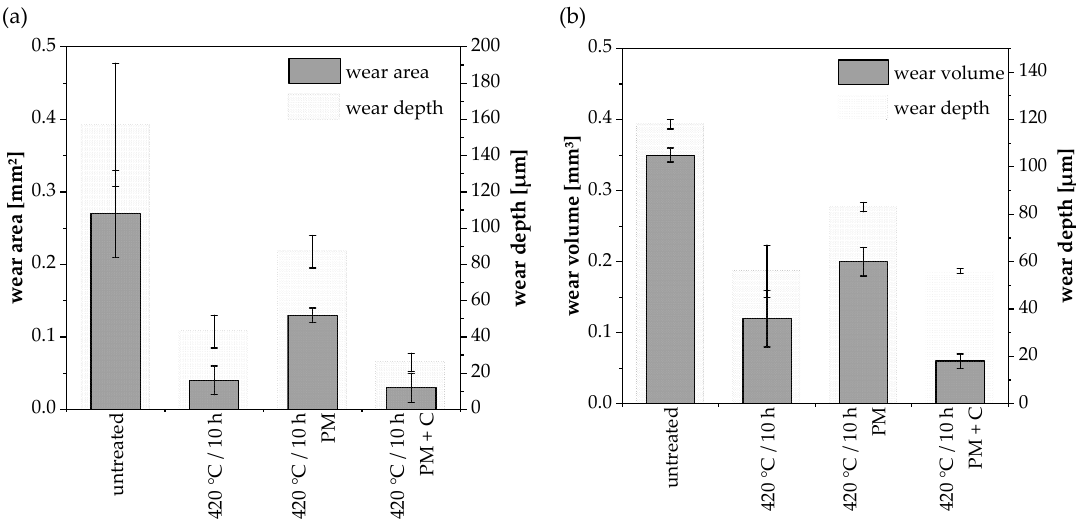
Figure 4. Results of the wear tests of AISI 316L coatings before and after gas nitriding, ( a ) ball-on-disk test and ( b ) reciprocating ball-on-plane test.